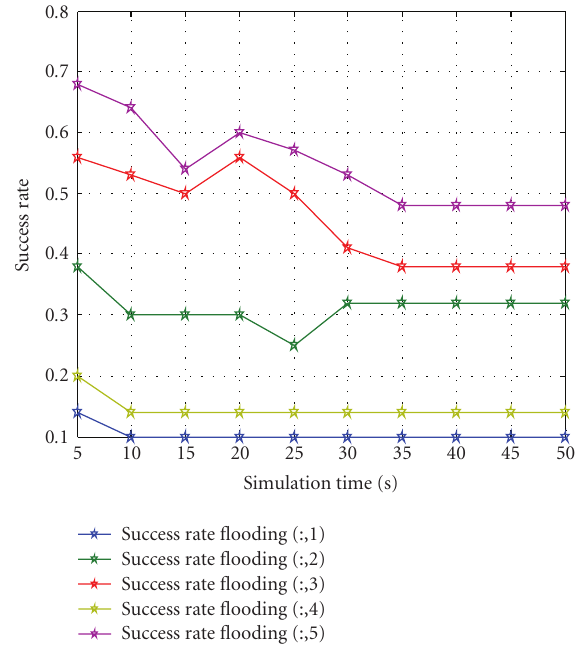
Figure 3: Simulation time and success rate.